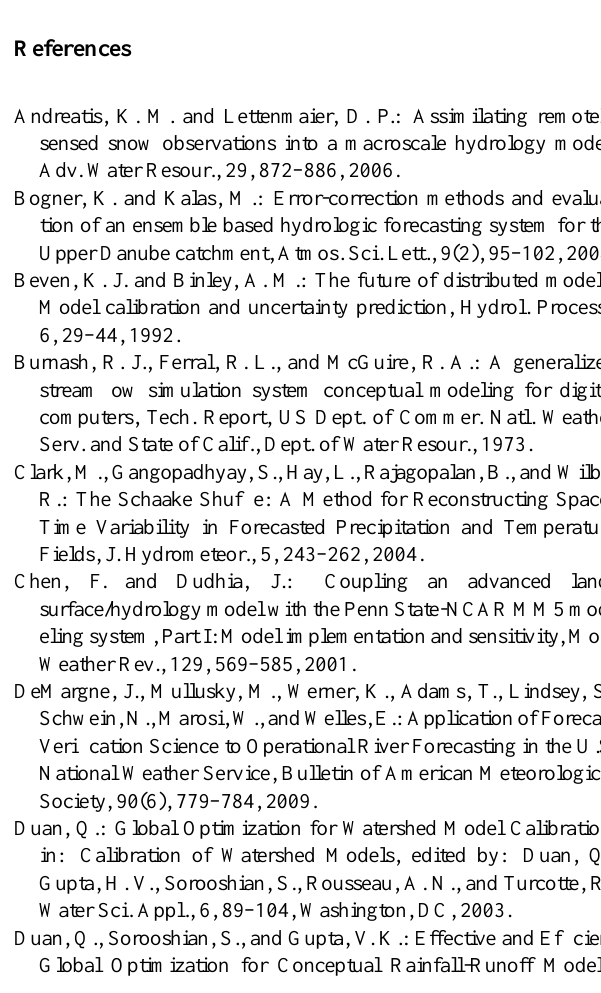
Fig. 8. The CDF curves of the raw, GLMPP adjusted and observed ensembles on two different forecast dates during the calibration and verification